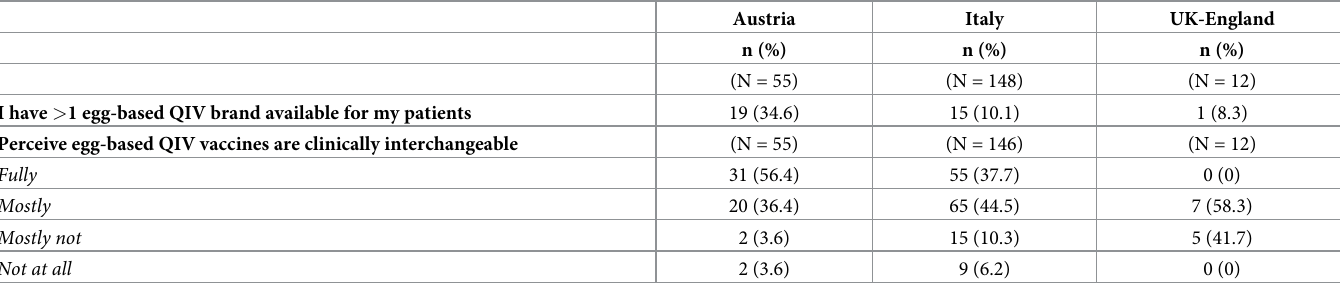
Table 7. Egg-based QIV brand availability and perceived clinical interchangeability, by country a